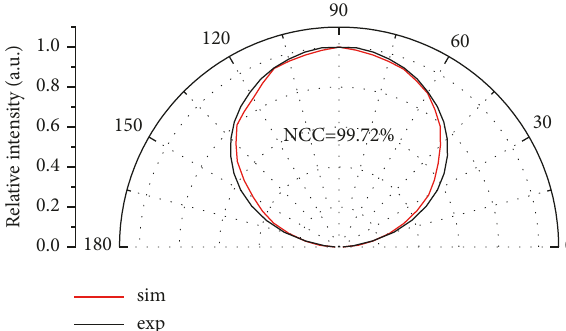
Figure 2: Comparison of light intensity distribution made by experiment and